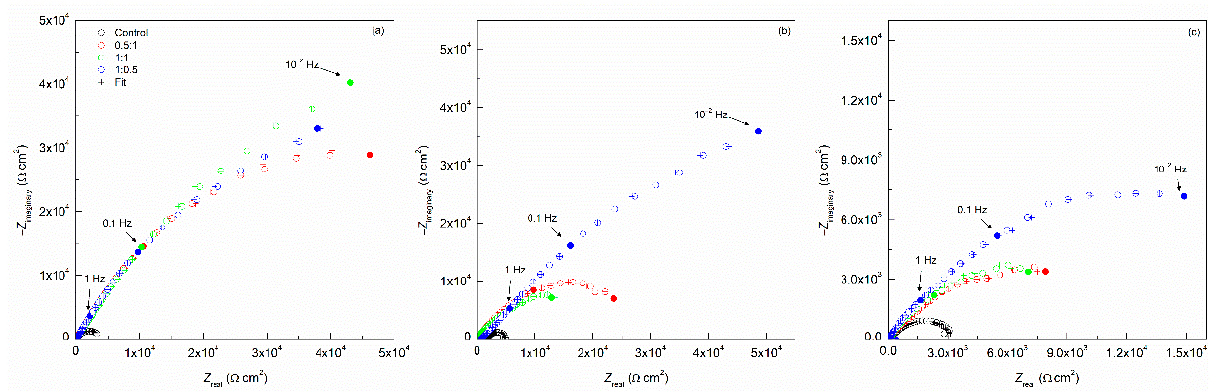
Figure 1. Nyquist plots of NaNO 2 and NaNO 3 obtained in simulated concrete pore solution contam- inated with 0.6 M NaCl under constant temperature of ( a ) 25 °C, ( b ) 35 °C, and ( c ) 45 °C.